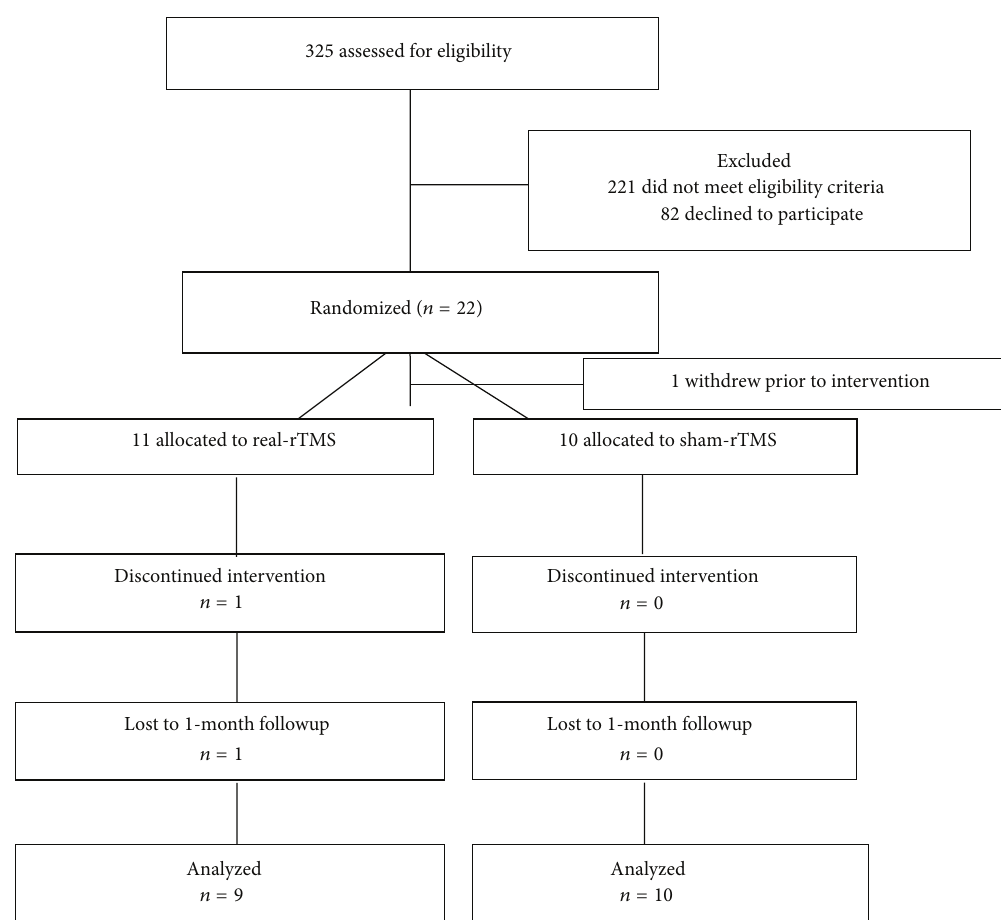
Figure 1: Flow of participants through the trial according to the CONSORT statement (rTMS, repetitive transcranial magnetic stimulation).